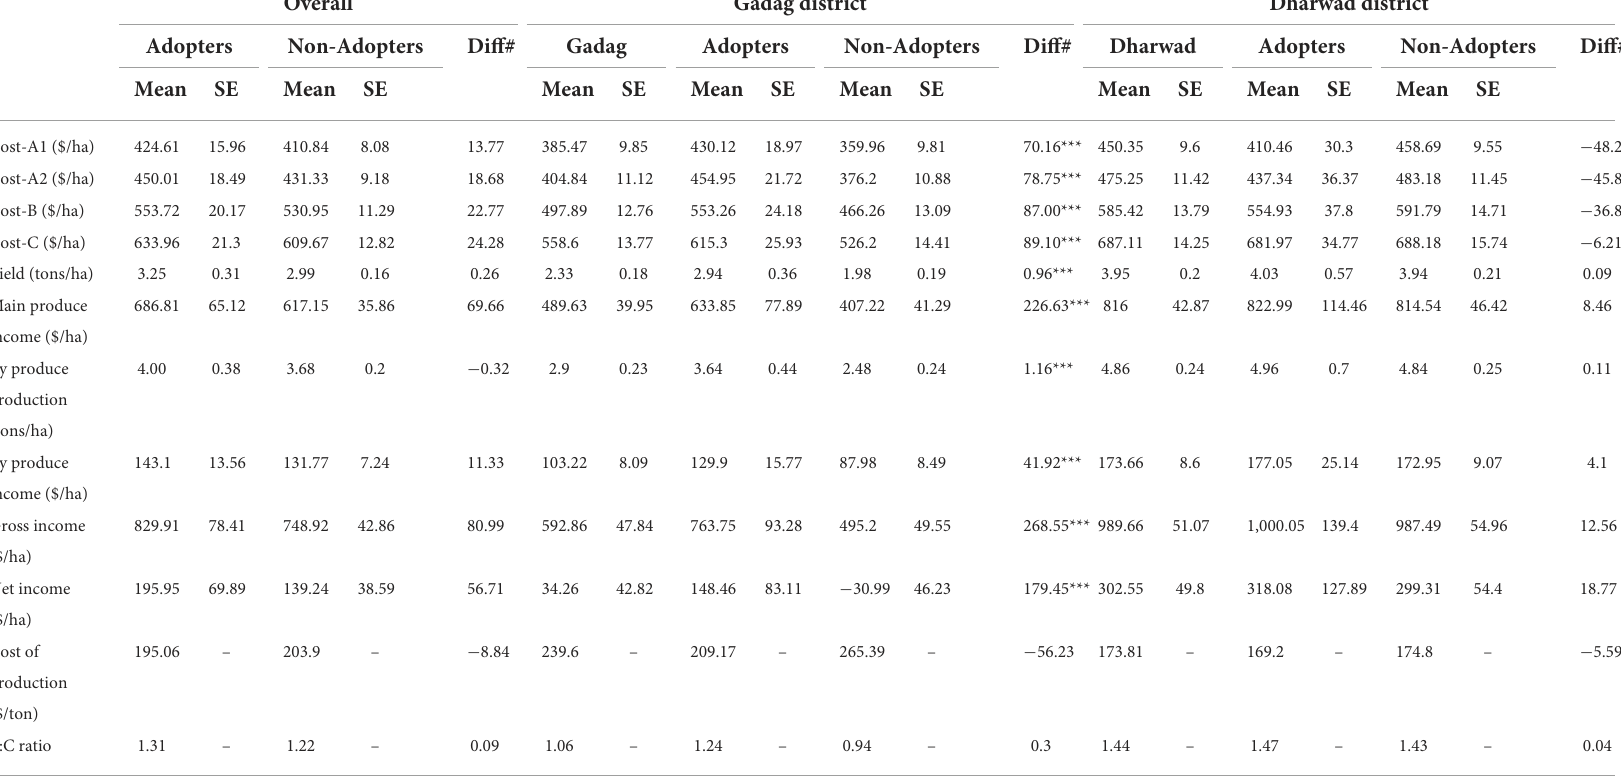
TABLE 2 Comparison of adopters and non-adopters of the stress-resilient maize hybrid in study locations (values in $/ha). Overall Gadag district Dharwad district Adopters Non-Adopters